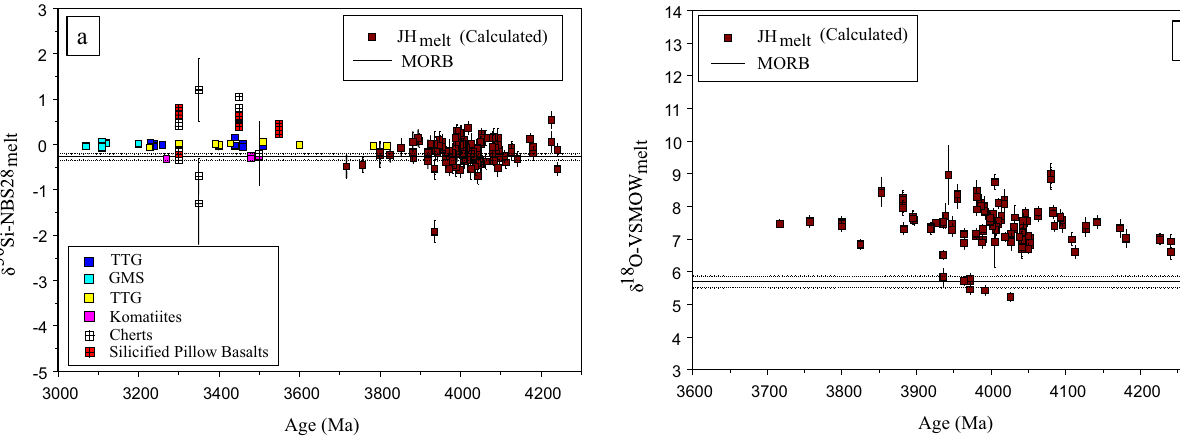
Fig. 3 | JH (Jack Hills) model melt Si and O isotope content plotted separately. a δ 30 Siof JHZ (Jack Hills Zircons) parent melts ( n =127) vs. age. Calculated JHmelts are compared to Archaean rocks. b δ 18 O of JHZ parent melts ( n =127) vs. age. Data